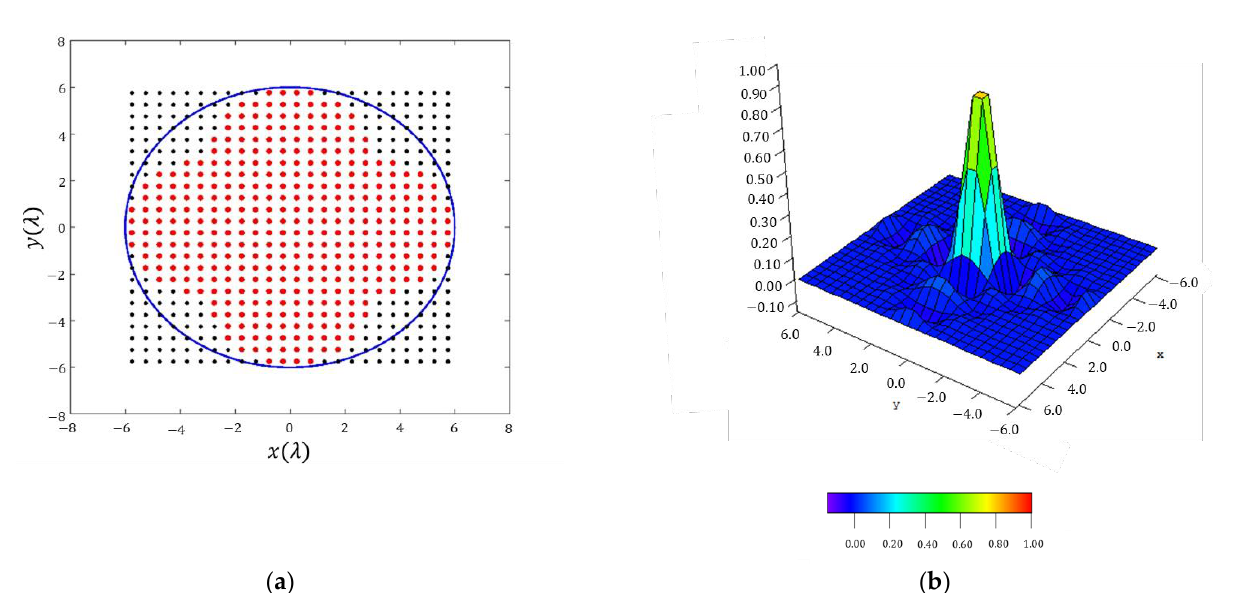
Figure 7. Discretized array antenna which generates the pattern of Figure 6: ( a ) antenna array configuration (the red dots represent the elements switched ON) within a rectangular lattice and for a maximum radius of 6 λ. ( b ) Normalized excitation currents of the array antenna.